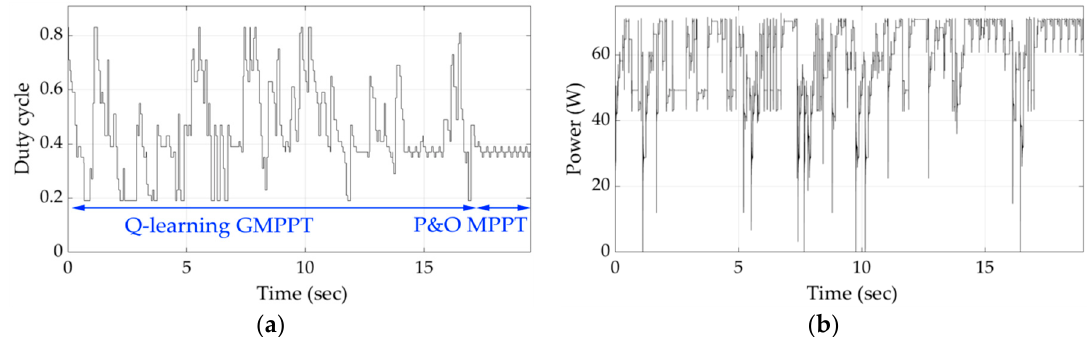
Figure 11. Results during execution of the proposed Q-learning-based GMPPT process for shading pattern 4: ( a ) duty cycle versus time and ( b ) PV array output power versus time.